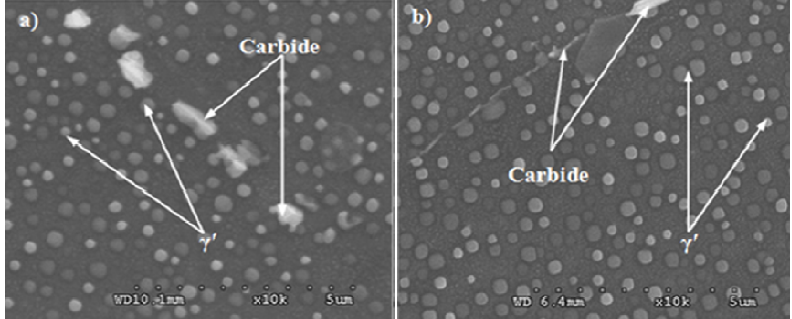
Figure 2. The precipitates of the nickel-base superalloy after heat treatment. ( a ) Pro.I; ( b ) Pro.II.